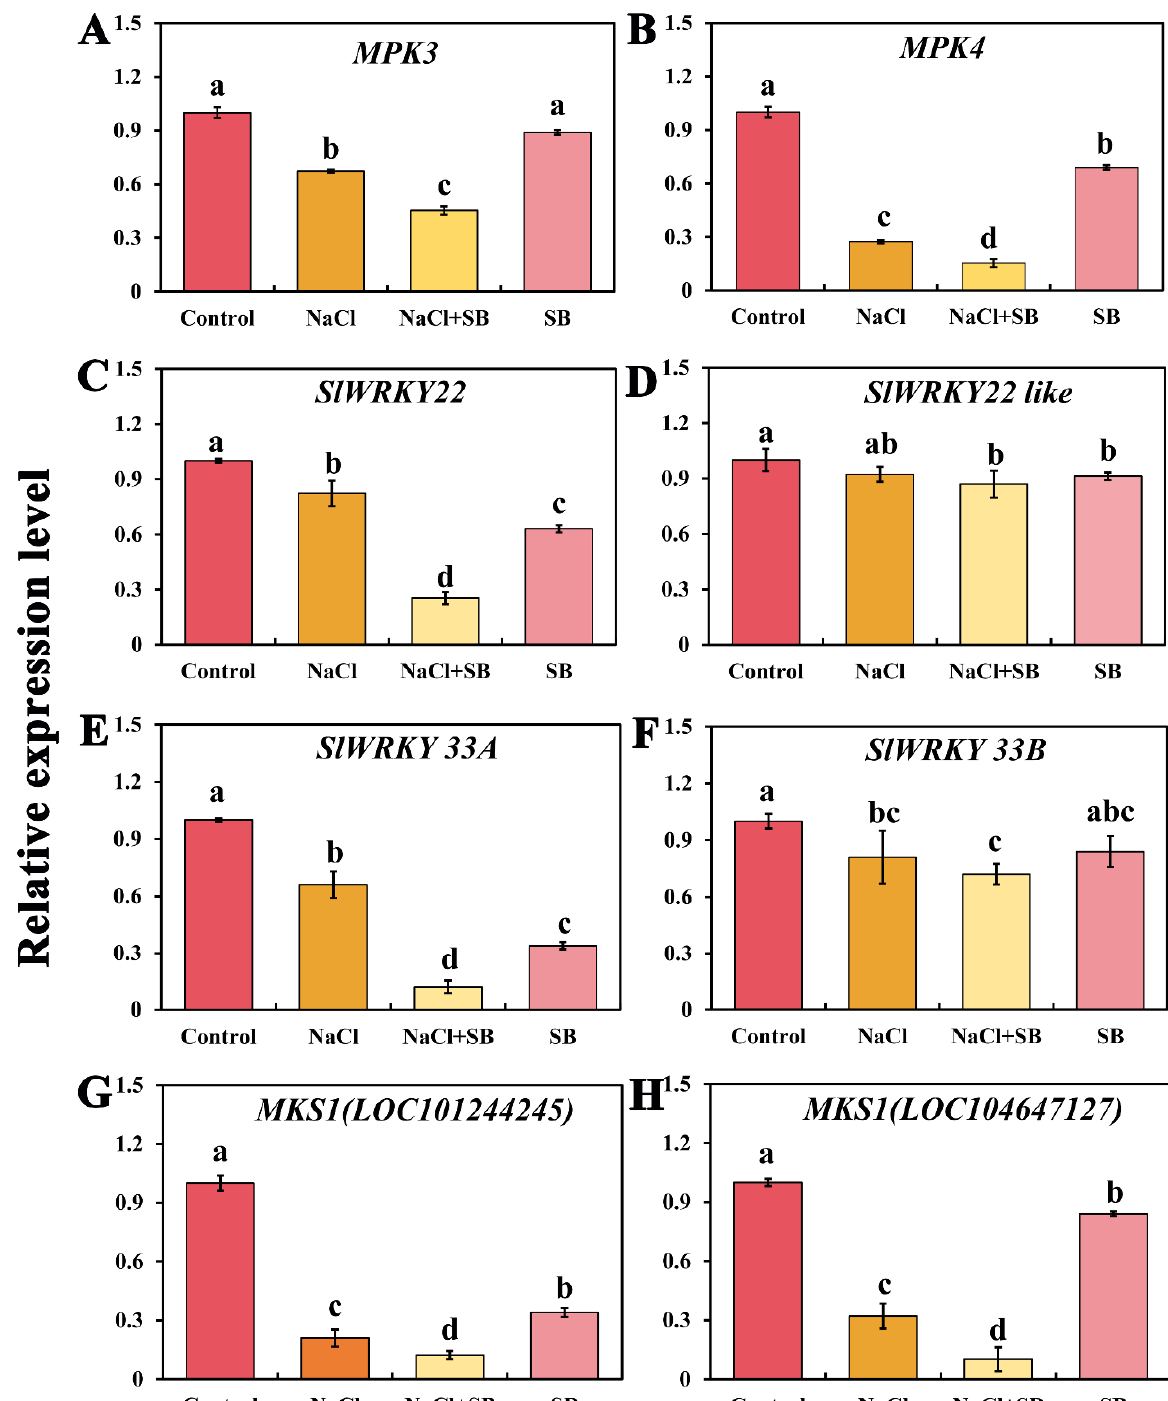
Figure 8. Effect of MAPK inhibitors SB203580 on the relative expression levels of genes related to defense response to pathogens. ( A ) MPK3 expression level, ( B ) MPK4 expression level, ( C ) SlWRKY22 expression level, ( D ) SlWRKY22 like expression level, ( E ) SlWRKY 33A expression level, ( F ) SlWRKY 33B expression level, ( G ) MSK1 (LOC 101244245) expression level, ( H ) MSK1 ( LOC 104647127) expression level. The values (means ± SE) are the averages of three independent experiments ( n = 15). Bars not sharing the same letters indicate statistically significant differences according to Duncan’s multiple range test ( p < 0.05).